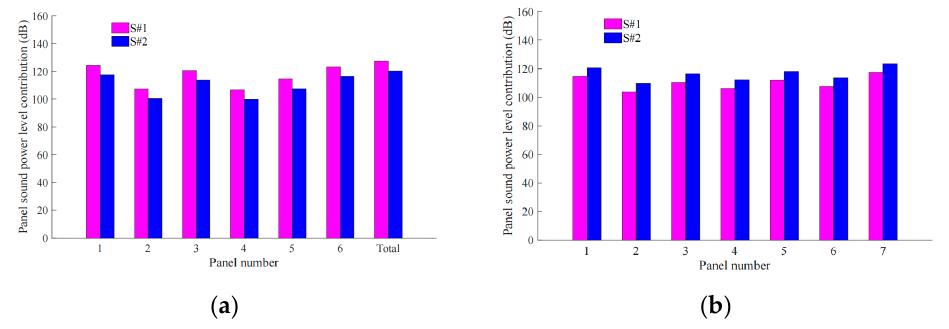
Figure 18. The panel sound power level contribution; ( a ) 50 Hz; ( b ) 56 Hz. Table 5. The difference in panel sound power level contribution.